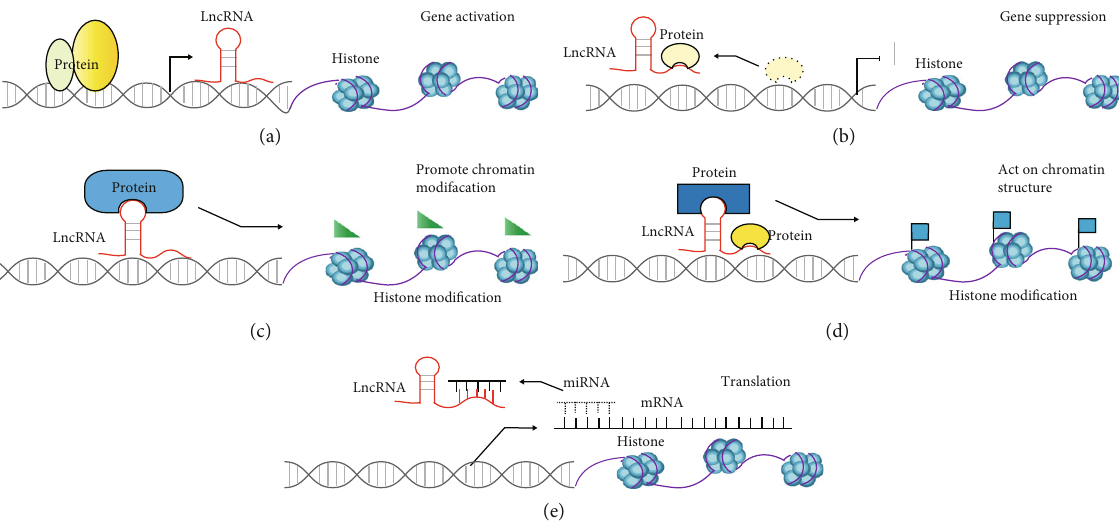
Figure 2: Schematic diagram of lncRNA mechanisms of action. Mechanisms of action: (a) signaling, (b) decoy, (c) guides, (d) sca ff old, and (e) miRNA